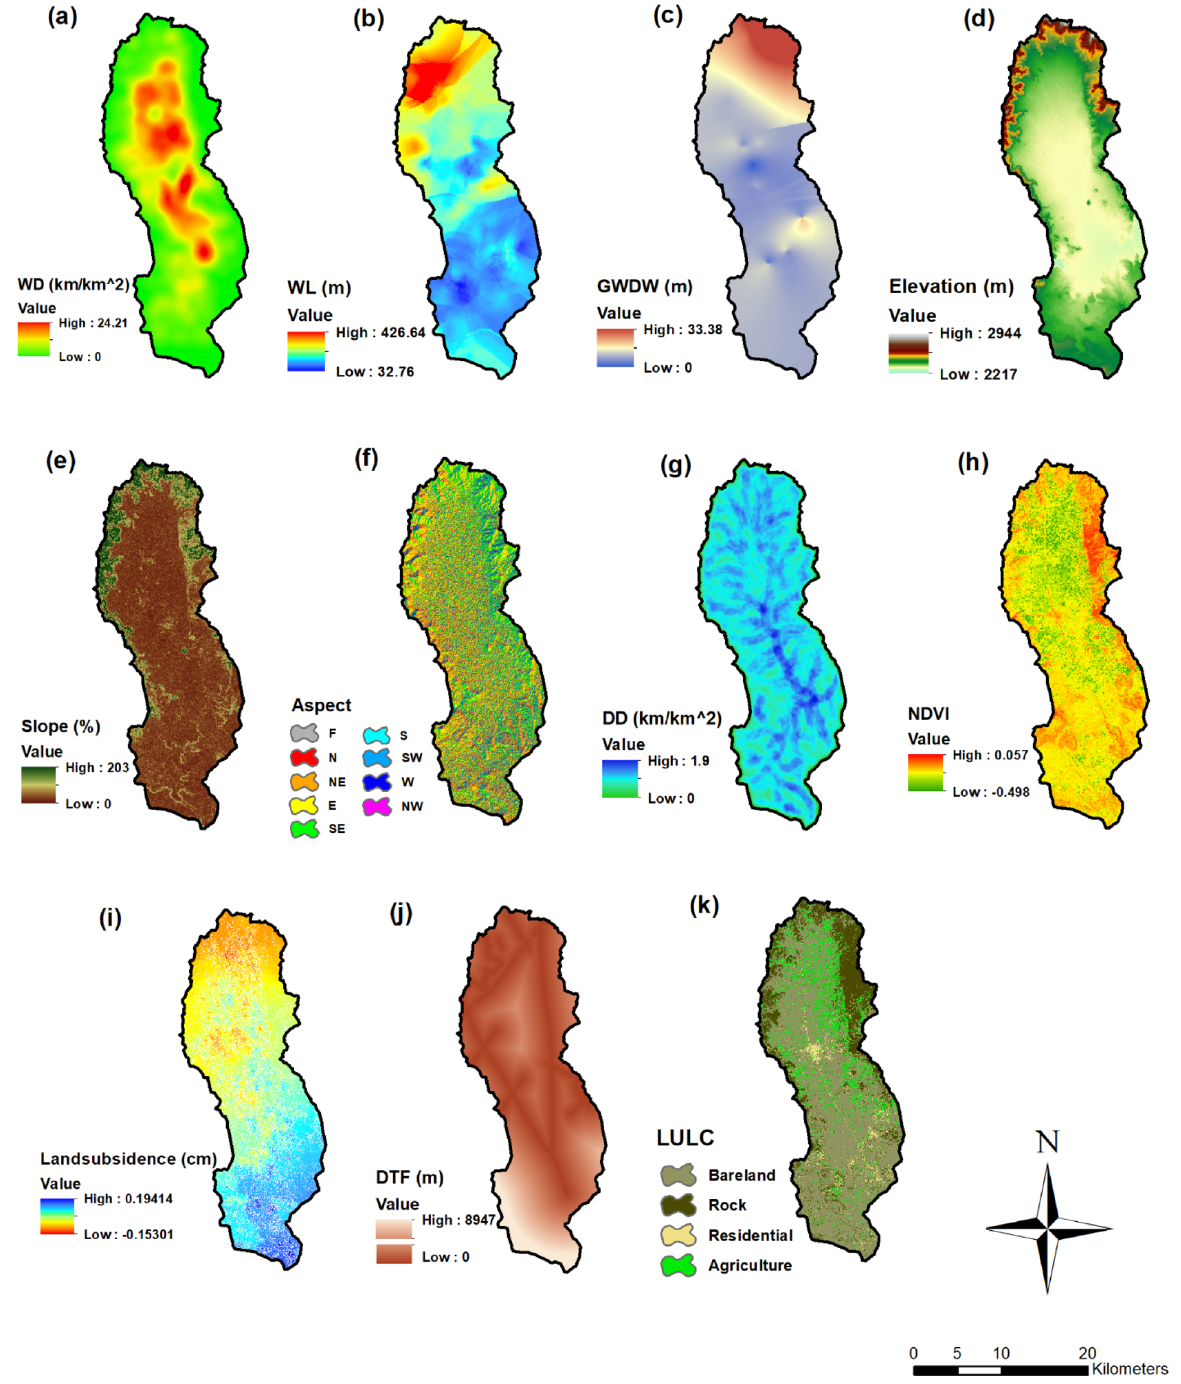
Figure 4. Earth fissure conditioning factors (Developed by the first author using ArcGIS (v. 10.3), https:// suppo rt. esri.